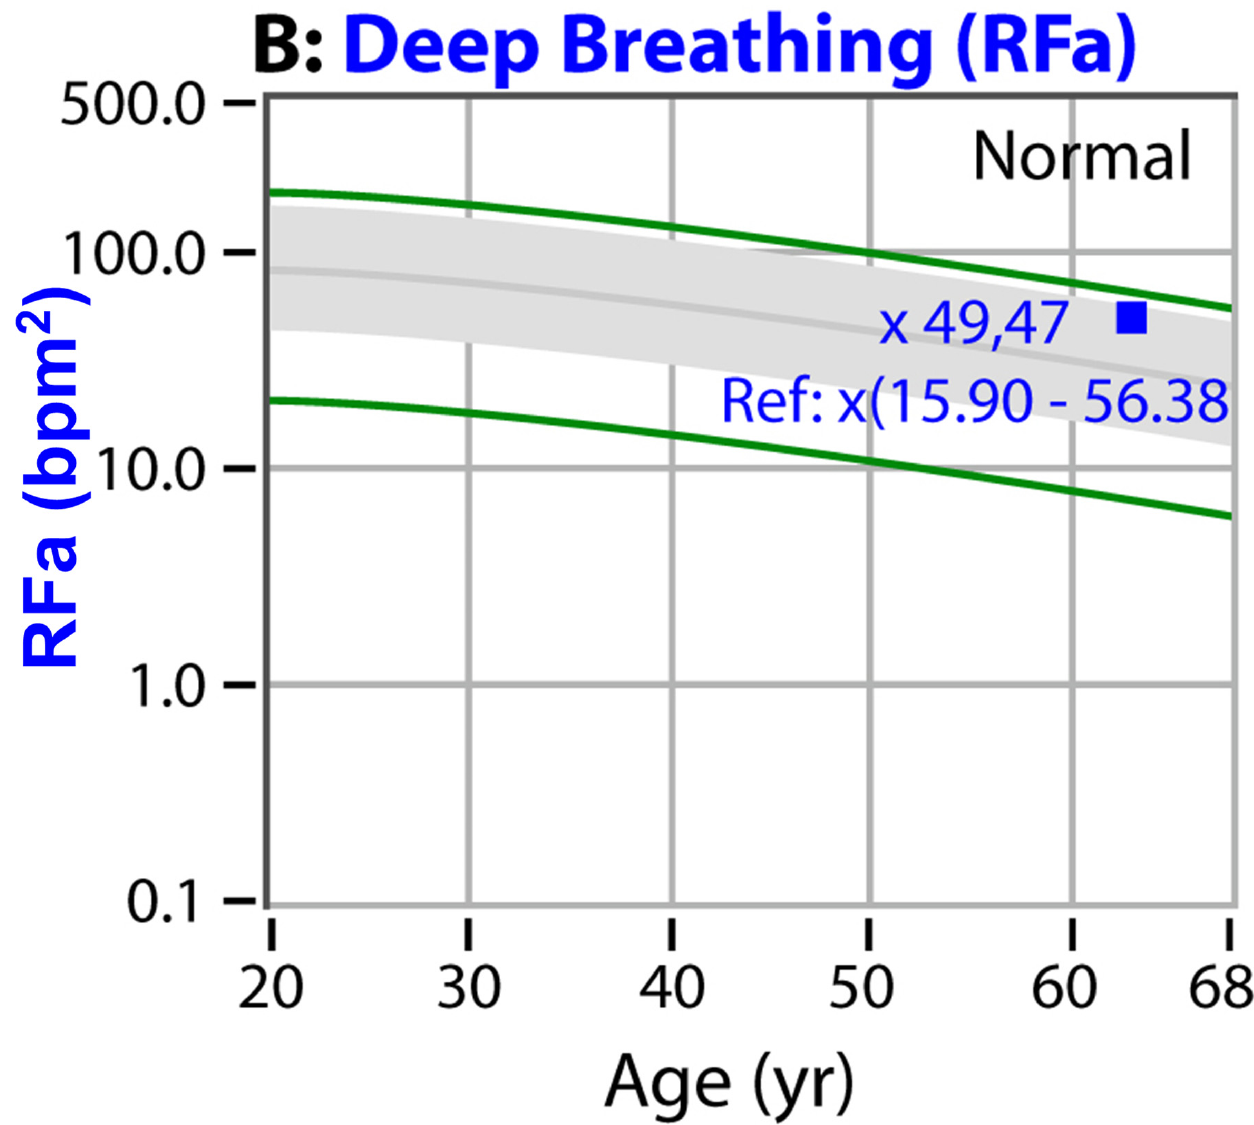
Figure 1. “Normal Response to Deep Breathing.” The deep breathing challenge is a well-known parasympathetic stimulus, and arguably one of the strongest of parasympathetic stimuli. The figure displays a deep breathing response plot demonstrating a normal parasympathetic response for a 63 y/o patient. The gray area indicates the normal region [18]. These data are both age-and baseline- adjusted [16]. The ’x’ preceding a number indicates that that number is baseline adjusted. The area between the green lines and the gray indicates borderline normal responses. Borderline low to low deep breathing responses are some of the earliest signs of PAN and risk of sudomotor abnormality or SFD.